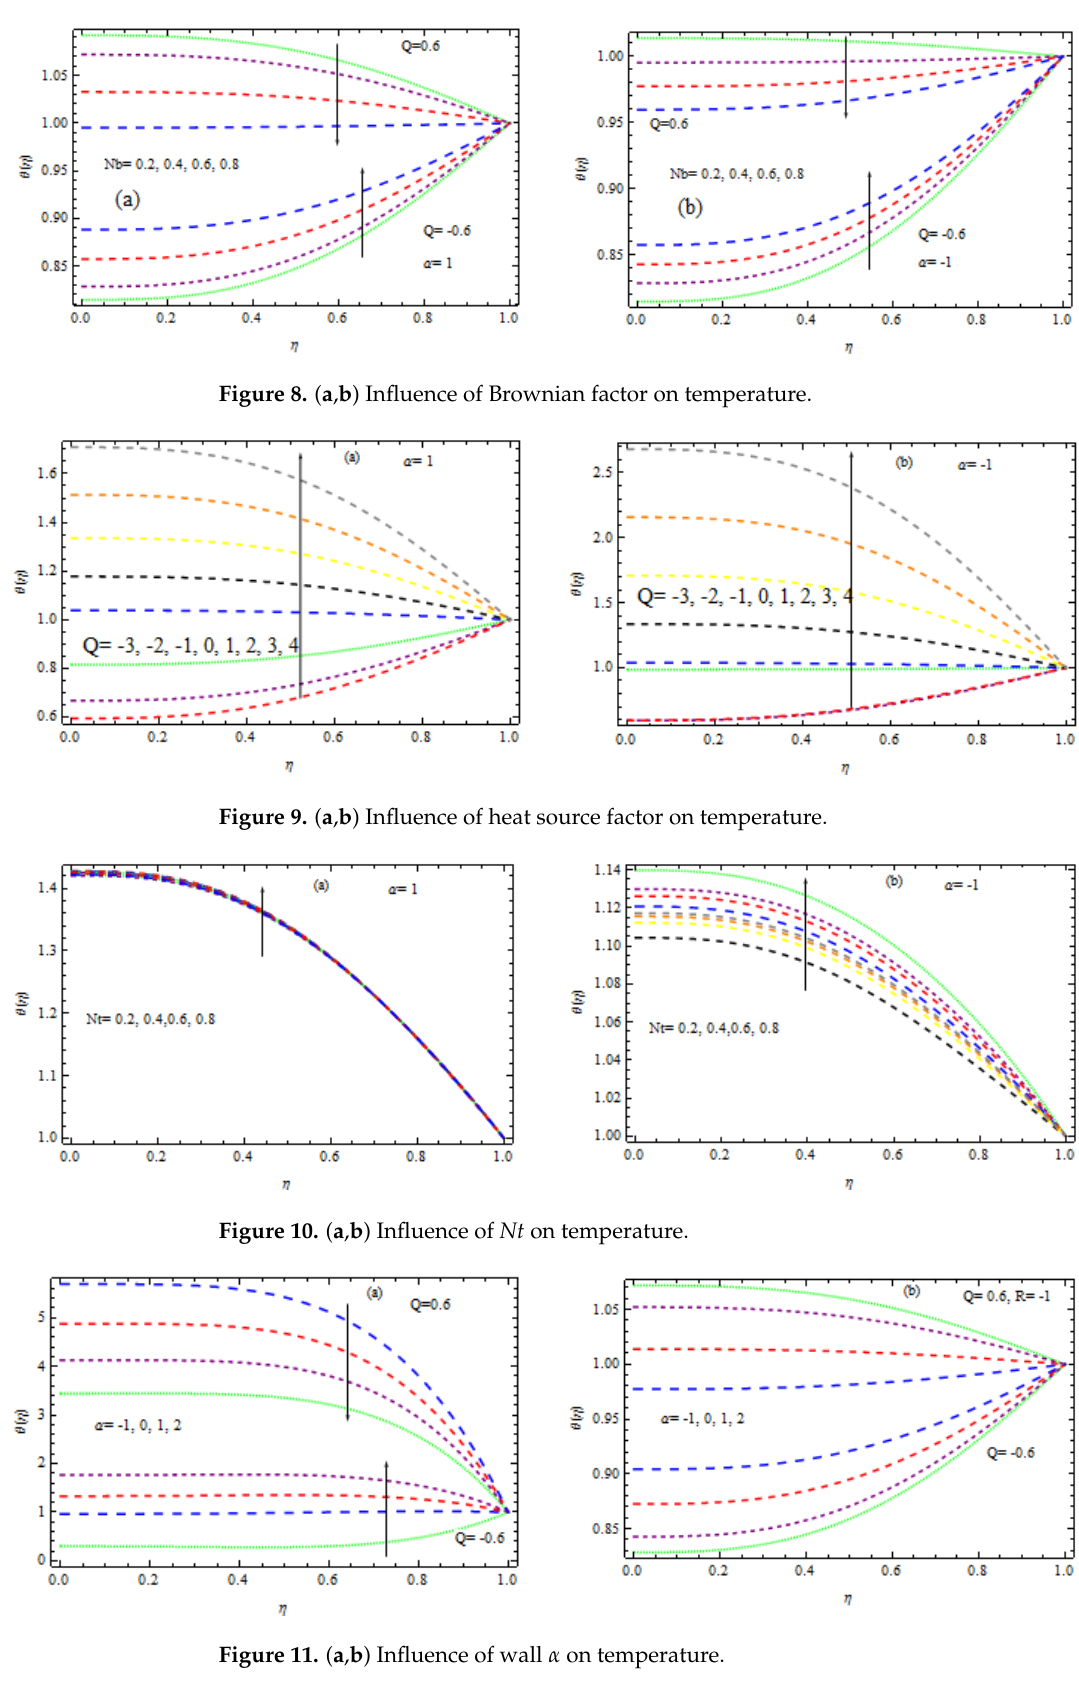
Figure 12. ( a , b ) Influence of 𝑀 on temperature. Figure 13. ( a , b ) Influence of Pr on temperature.